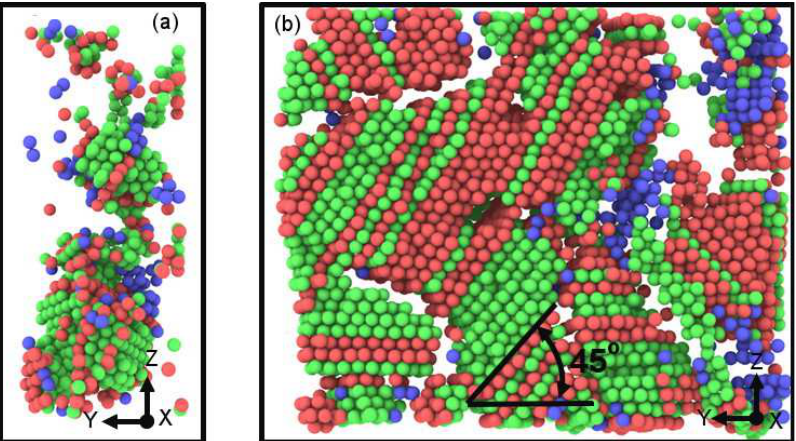
Figure 15. Crystal structure of the different chips. ( a ) Crystal structure of the spherical chip; and ( b ) crystal structure of strip chip. Green, red, blue and white are FCC, HCP, BCC and other structural atoms respectively.